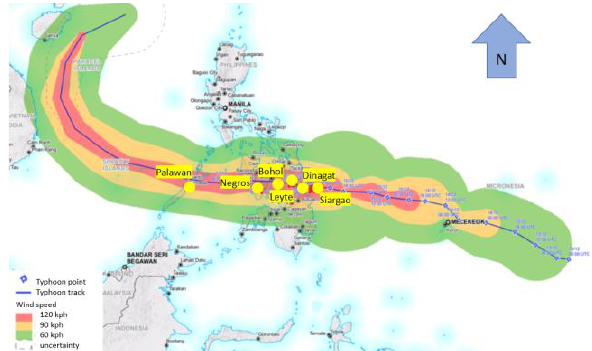
Figure 1. Path of Typhoon Rai which affected areas in the central and southern Philippines. Points indicate location map of the study areas (i.e. selected municipalities in Palawan, Negros, Bohol, Leyte, Dinagat, and Siargao). Adapted from (OCHA,